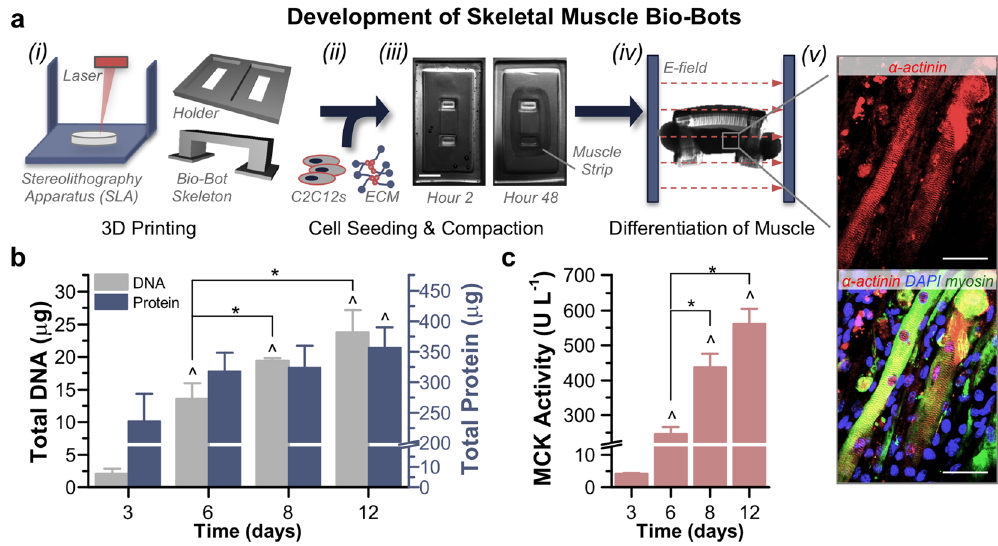
Figure 1. Development and Differentiation of Skeletal Muscle Bio-Bots. ( a ) Modular bio-bots were assembled and differentiated in a stepwise manner. (i) A Stereolithography apparatus (SLA) was used to 3D print a millimeter-scale hydrogel skeleton and holder. (ii) C2C12s were mixed with a liquid solution of ECM proteins that included fibrinogen, thrombin and Matrigel. (iii) When added to the holder, the cell-gel solution compacted to form a solid muscle strip. Scale bar, 2 mm. (iv) The freestanding bio-bot (consisting of the muscle strip coupled to the hydrogel skeleton) could be released from the holder and subjected to electrical or optical stimulation. (v) Immunostaining revealed the presence of striated and multinucleated myotubes ( α -actinin, red; MF-20 myosin, green; DAPI nuclear stain, blue). Scale bar, 50 μ m. ( b ) Total DNA and protein levels increased over the time course of the experiment ( n = 3–4 muscle strips per time point). There was no statistically significant difference in protein/DNA ratios between days 8 (17 ± 2.8 μ g protein μ g DNA − 1 ) and 12 (15.7 ± 2.5 μ g protein μ g DNA − 1 ). ( c ) Muscle creatine kinase (MCK) activity was significantly increased as early as day 6 and reached a maximum output on day 12 ( n = 3 muscle strips per time point). The rate of increased MCK activity slowed between days 8 and 12, confirming that this was a relevant stopping point for the experiments. All plots represent mean ± SEM. * indicates significance ( p < 0.05) between conditions at the same time point; ^ indicates significance compared to initial time